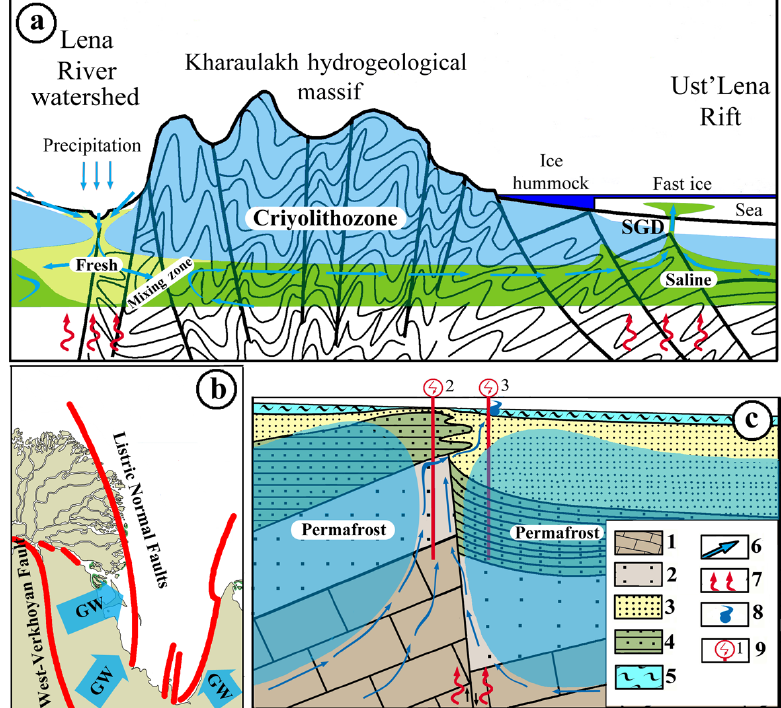
Figure 15. The mechanistic scheme of recharge, transport, and discharge of pressurized submarine GW. (a) The general vertical scheme of recharge, transport, and discharge of pressurized submarine GW. (b) The spatial scheme of GW transport in the Kharaulakh hydrogeological massif. (c) The vertical scheme of GW transport and submarine discharge instead of tectonogenic talik based on TEM and drilling data. (1) Metamorphic bedrock of pre-upper Cretaceous complexes, (2) substratum, (3) sand, (4) aeolian Quaternary material, (5) recent bottom sediments, (6) direction of GW movement, (7) geothermal flux, (8) SGD, (9) place and number of TEM